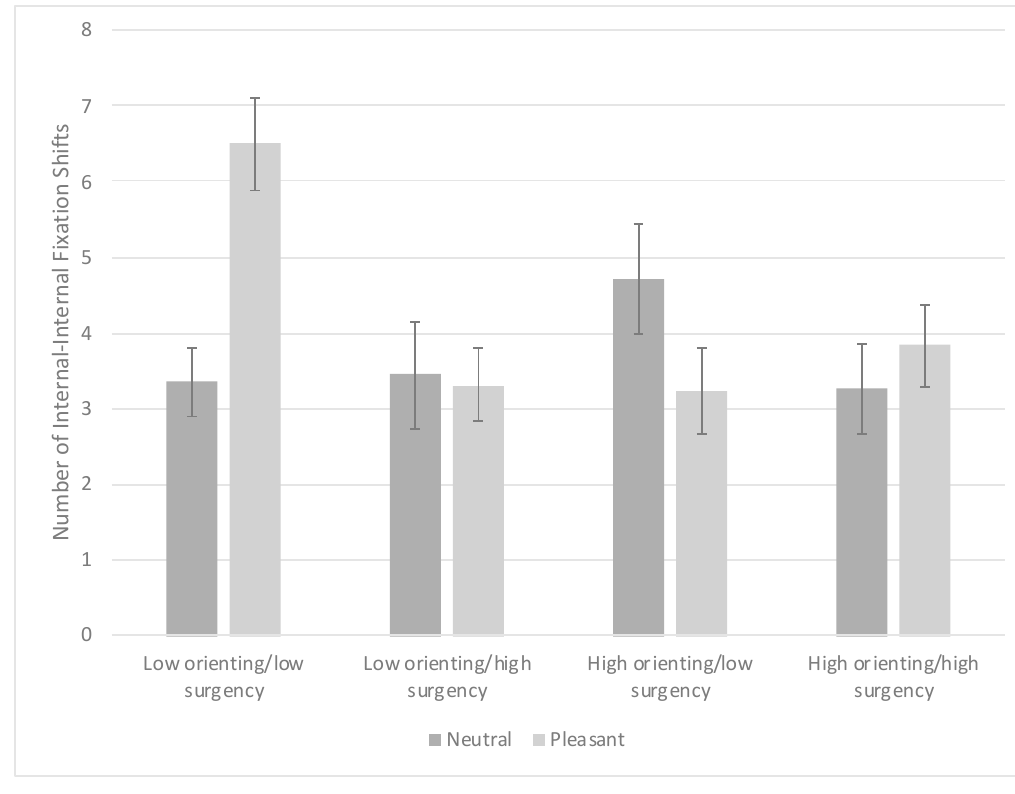
Figure 7. Number of fixation shifts between the internal features of the familiarized face based on facial expression and infants’ orienting and surgency. Bars represent standard error.